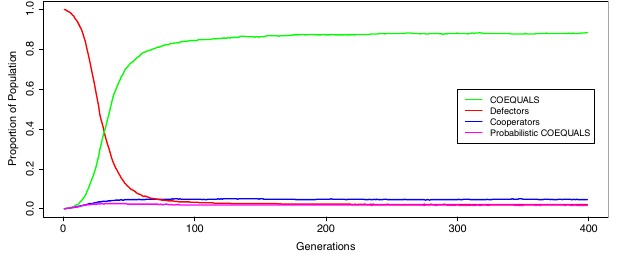
Figure 6. Robustness of COEQUALS to a variant that defects probabilistically with agents possessing the same wealth. Adopters of COEQUALS cooperate with certainty in every PD game they enter, thus raising questions about whether a variant of COEQUALS that defects with some probability in any game of a generation might outcompete the purely cooperative, baseline version of COEQUALS. Results presented in Fig. 6 show that this possibility does not materialize. The figure presents the median of the distribution of population shares of each strategy in every generation of the simulation. The results show selection against a variant of COEQUALS that probabilistically defects. Across generations, the median of the variant’s population shares reaches a maximum value of 0.025 and it dwindles beneath that value in the remaining generations, resulting in a final value of 0.016 in g = 400. To the contrary, the distribution of population shares for the purely cooperative form of COEQUALS centers on a median value that grows across generations. By the 200 th generation, the median of COEQUALS’ distribution of population shares rests on a value of 0.872, which grows to its maximum value of 0.881 by the final round of the simulation. The corresponding metrics for defectors and cooperators remain at low values over those same generations, thus suggesting that the conventional form of COEQUALS remains robust to all strategies in the presence of a variant of itself that probabilistically defects. This result is consistent with the idea that COEQUALS uses wealth holdings to generate positive assortment: in such conditions, defecting on others with equal wealth holdings reduces the overall fitness of the strategy and leads to missed opportunities for mutual